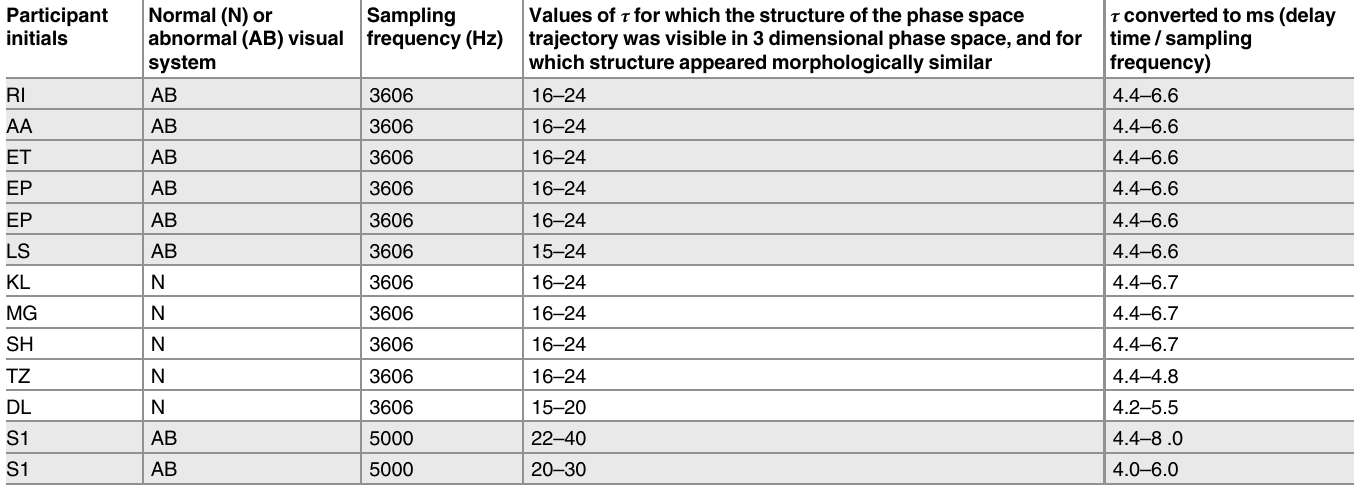
Table 1. Range of values for τ for VEPs recorded at > 1000 Hz such that reconstructed phase space trajectories were not stretched along the diago- nal such that fluctuations in the trajectory were evident.